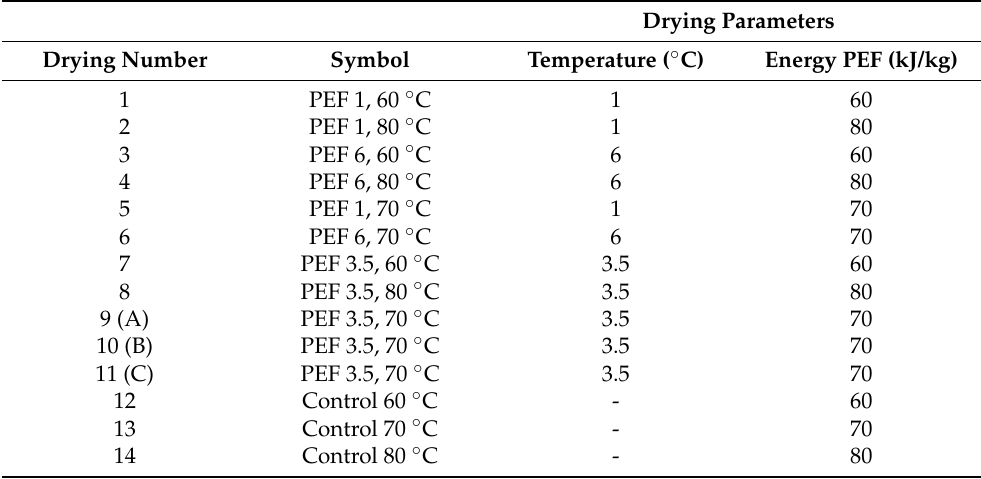
Table 3. List of dryings, taking into account the temperature and energy supplied during application of the PEF pretreatment—experiment